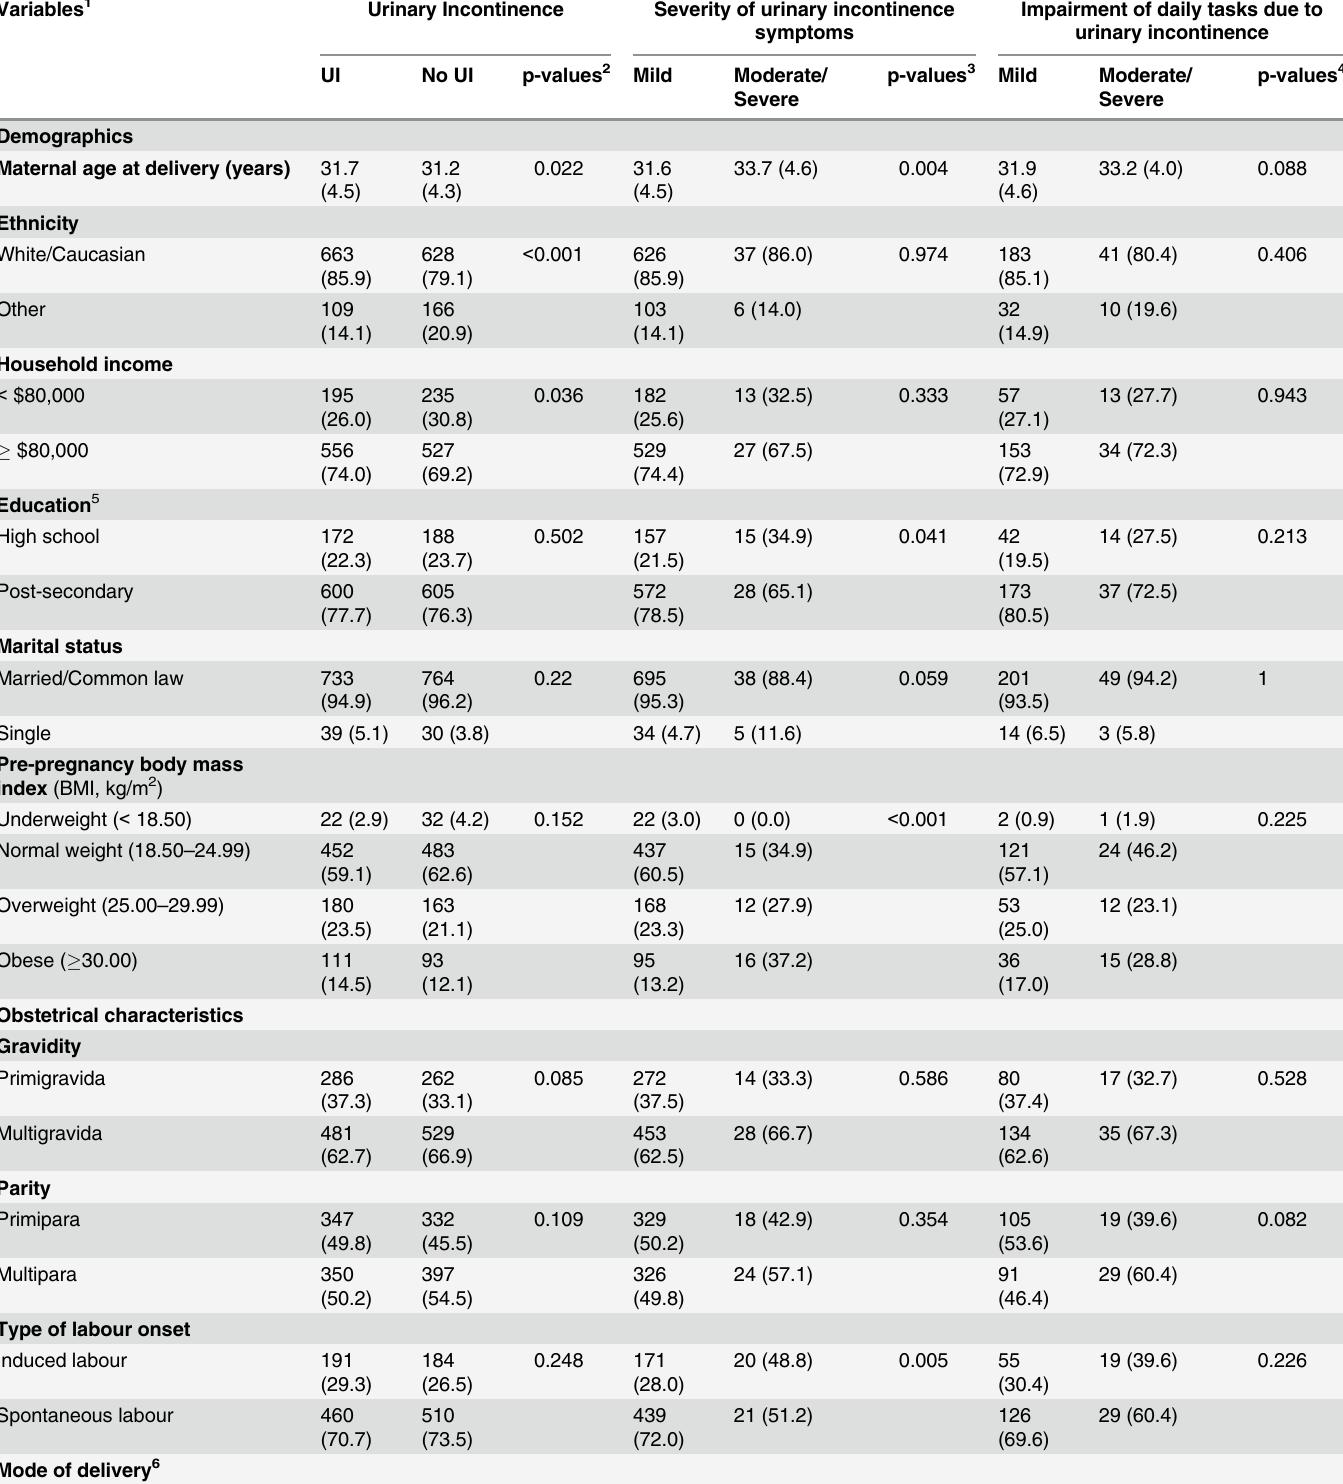
Table 4. Severity of symptoms and level of impairment of daily tasks due to urinary incontinence at 12 months